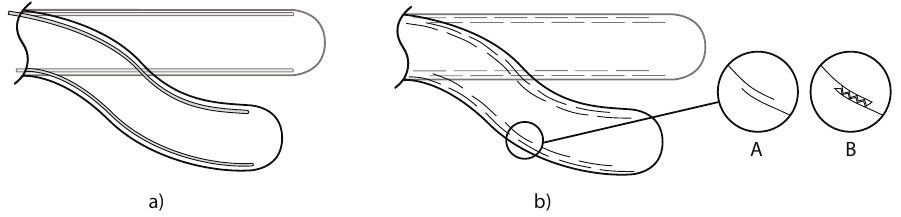
Figure 4. ( a ) Wire jamming solution: the wire can be free to move giving a flexible state, but once they are locked by an external force, as their length are fixed, the shape is locked and the stiffness is increased; ( b ) layer jamming solution: the layers are segmented over the length of the solution and can slide over each other in the flexible state, while the rigid state locked them by: ( A ) friction over flat plates; ( B ) shape